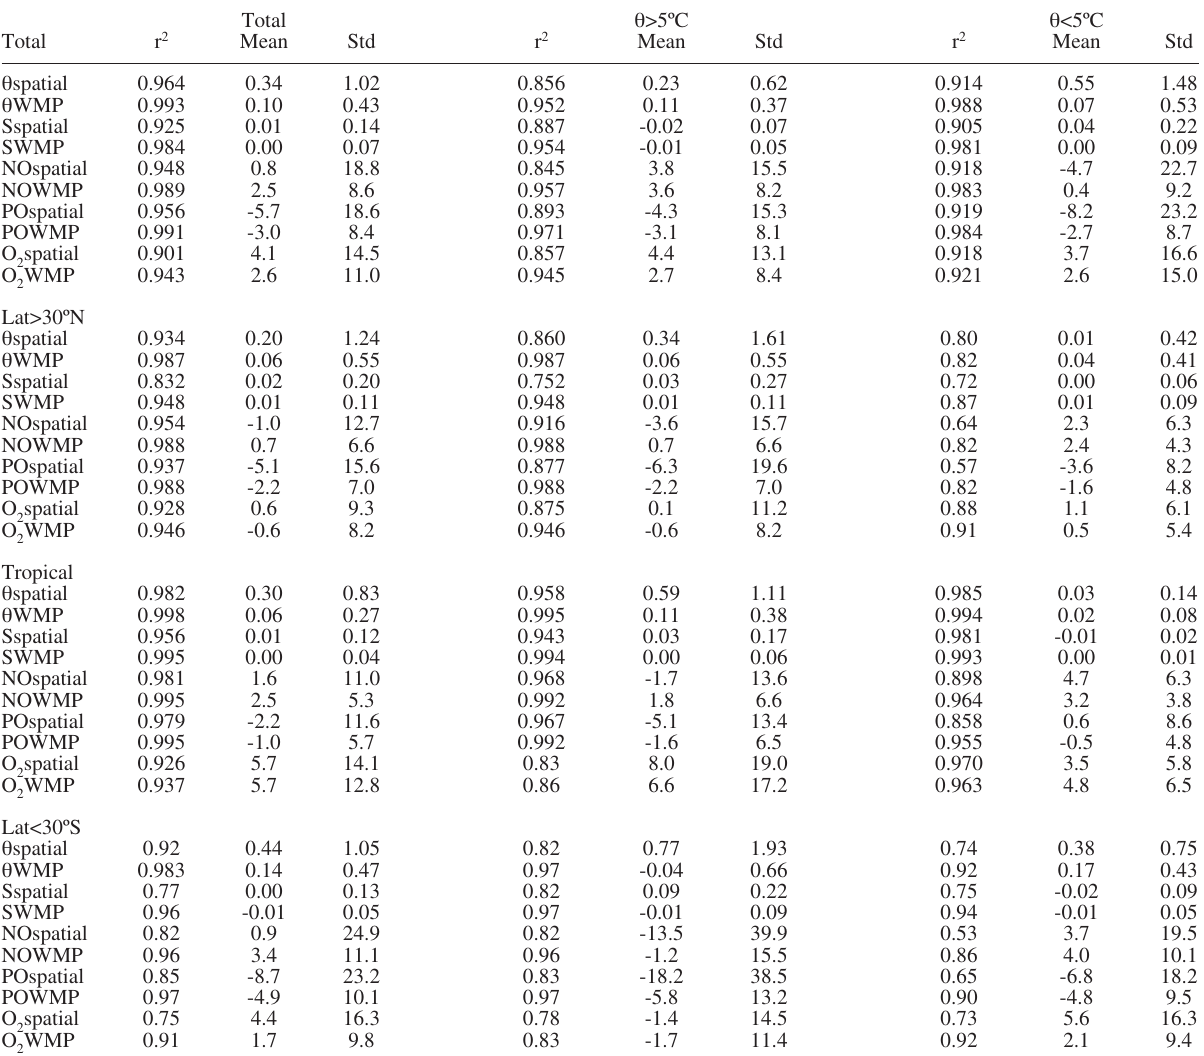
Table 1. – Mean and standard deviation (STD) of the interpolated data minus WOA05 data are computed for the whole Atlantic, for specific sub domains and for the spatial and WMP interpolation. The determination coefficient (r 2 ) between WOA05 and interpolated fields is also provided. Temperature is in ºC, Salinity in psu and NO , PO and O in µmol kg -1 2